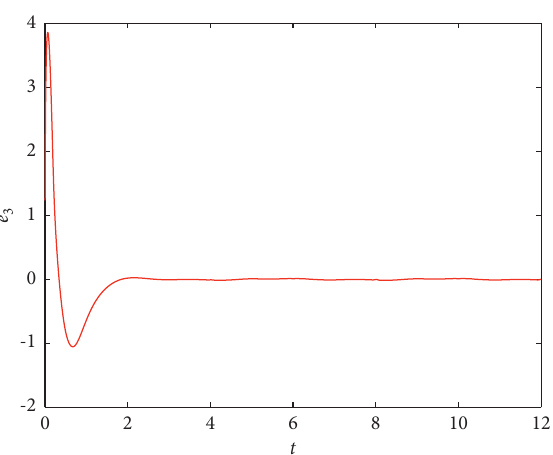
Figure 11: State error e